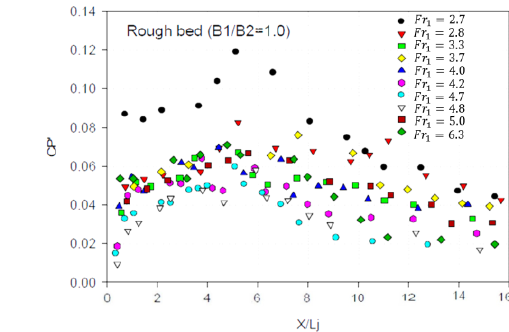
Figure 5. C P (cid:48) parameter in a prismatic Figure 5. 𝐶 𝑃′ parameter in a prismatic jump.